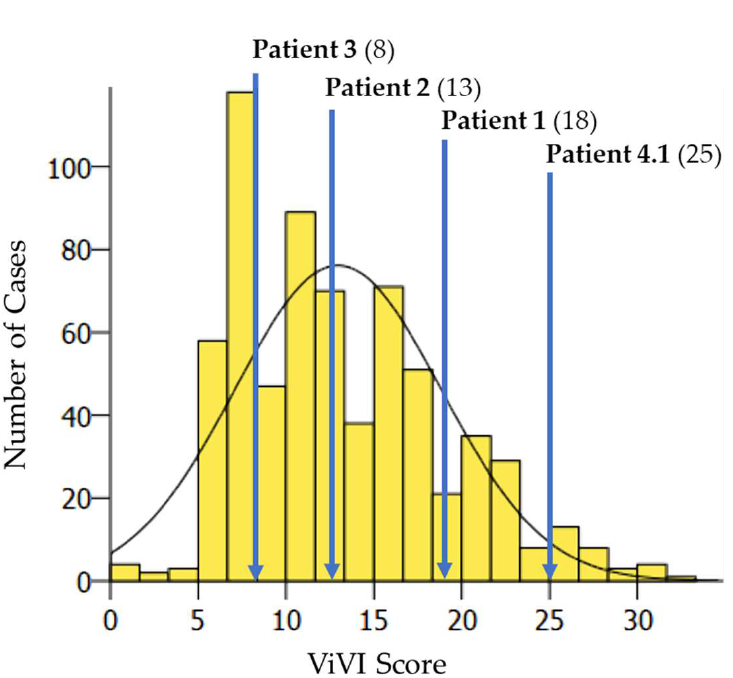
Figure 3. Distribution of disease severity (ViVI Scores) of cases with IV dual infection ( n = 4) amongst all IV-positive patients ( n = 673, median ViVI Score: 12.0, mean ViVI Score: 13.0).